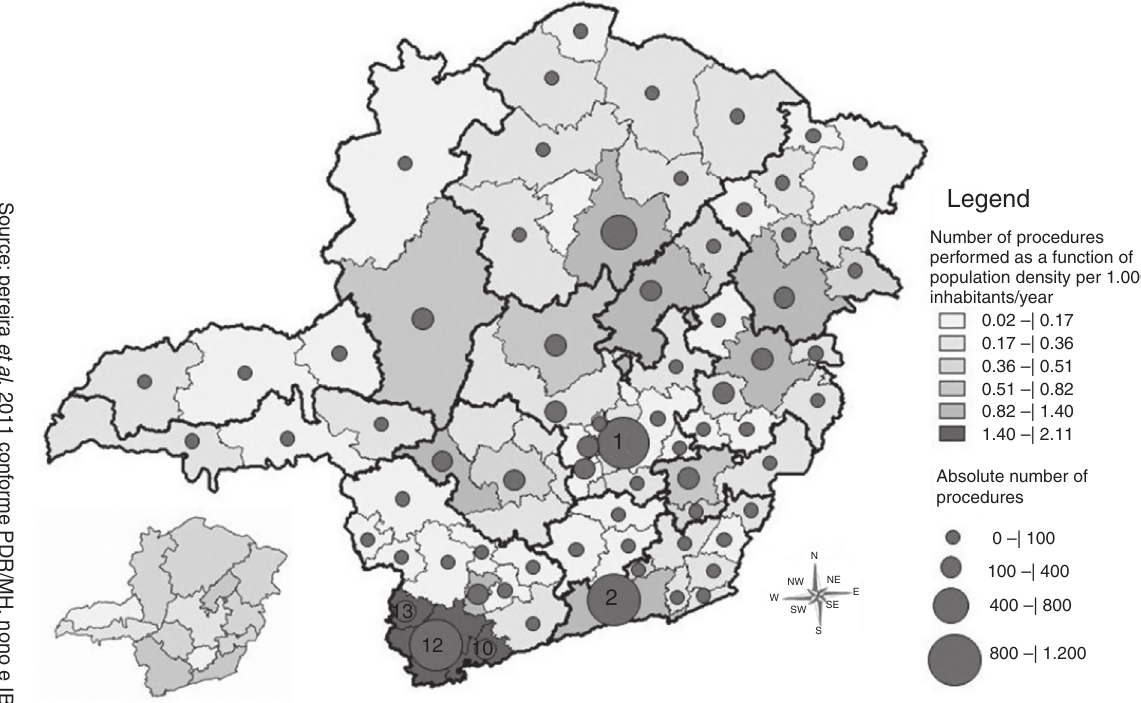
Spatial distribution according to micro- and macro-region of the ‘‘Speech and Hearing Therapy’’ procedure per 1000 inhab./year and